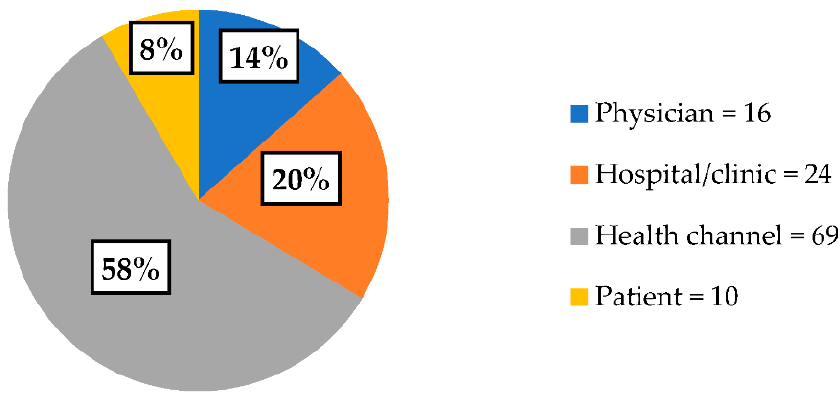
Figure 2. Source of upload for videos on meningiomas.